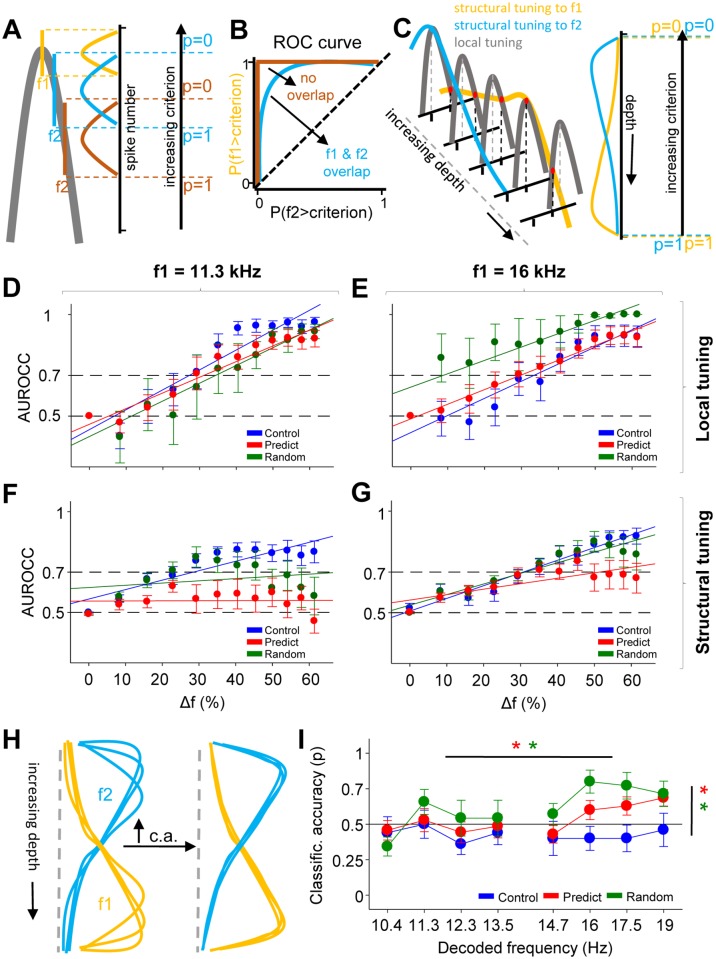
Predictable sound exposure leads to increased overlap in structural
tuning and better classification accuracy.(A) Scheme that illustrates the computing of the ROC curves using the
local tuning curves, in which f1 is the BF. (B) Scheme that illustrates
the example of a ROC curve. (C) Same as D but for the structural tuning.
(D) AUROCC calculated from the tuning curves with BF of 16 kHz ± 1.1%
(tuned region) across groups and ΔF. Each point is the comparison
between an f1 of 16 kHz and an f2 of a frequency separated by a given
ΔF. (ANOVA, group F2,324 = 11.78, p <
0.0001, ΔF F11,324 = 14.49, p < 0.0001).
Animals: control n = 10; predictable n
= 14; random n = 7. Corrected pair comparisons:
p < 0.0001 random versus control,
p < 0.0001 random versus predictable. (E) Same
as D for tuning curves with BF of 11.31 kHz 1.1% (adjacent region).
Here, f1 was 11.3 kHz throughout. (ANOVA, group F2,552 =
8.17, p < 0.0001, ΔF F11,552 = 17.08,
p < 0.0001). Animals: control n
= 10; predictable n = 14; random n =
7. Corrected pair comparisons: p = 0.019 random versus
control, p = 0.0003 predictable versus control. (F)
AUROCC calculated from the structural tuning curves with BF of 16 kHz ±
1.1% (tuned region) across groups and ΔF. Each point is the comparison
between the mean of responses to f1 of 16 kHz and individual responses
to f2. (ANOVA, group F2,336 = 9.37, p =
0.0001, ΔF F11,336 = 12.1, p < 0.0001).
Animals: control n = 10; predictable n
= 14; random n = 7. Corrected pair comparisons:
p = 0.0003 predictable versus control,
p = 0.0053 predictable versus random. (G) Same as
in F, using an f1 of 11.3 kHz. (ANOVA, group F2,335 = 33.34,
p < 0.0001, ΔF F11,335 = 3.94,
p < 0.0001). Animals: control n
= 10; predictable n = 14; random n =
7. Corrected pair comparisons: p < 0.0001
predictable versus control, p = 0.023 random versus
control, p = 0.0001 predictable versus random. (H)
Scheme illustrating the relationship between ROC and classification
accuracy (labeled “c.a.”). Upward arrow equals increased classification
accuracy. (I) Mean classification accuracy probability for frequencies
in the adjacent (BF of 10–13 kHz) and tuned (BF of 16–19 kHz) regions.
Error bars represent SEM. (ANOVA, group F2,247 = 7.37,
p = 0.0008, region F1,247 = 5.78,
p = 0.017, frequency F3,247 = 2.49,
p = 0.061. In the tuned region: ANOVA, group
F2,123 = 9.44, p = 0.000, corrected pair
comparisons: p = 0.011 predictable versus control,
p = 0.0001 random versus control. For control
group: ANOVA, region F1,79 = 0.07, p = 0.78.
For predictable group: ANOVA, region F1,111 = 4.04,
p = 0.046. For random group: ANOVA, region
F1,55 = 7.01, p = 0.010). Animals:
control n = 10; predictable n = 14;
random n = 7. Numerical data for this figure found in
S1
Data. AUROCC, area under the ROC curve; BF, best frequency;
ROC, receiver operating characteristic.